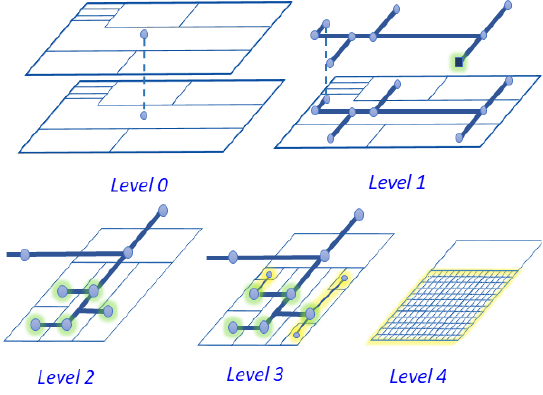
Figure 4. The Five Levels of detail for representing indoor navigation networks